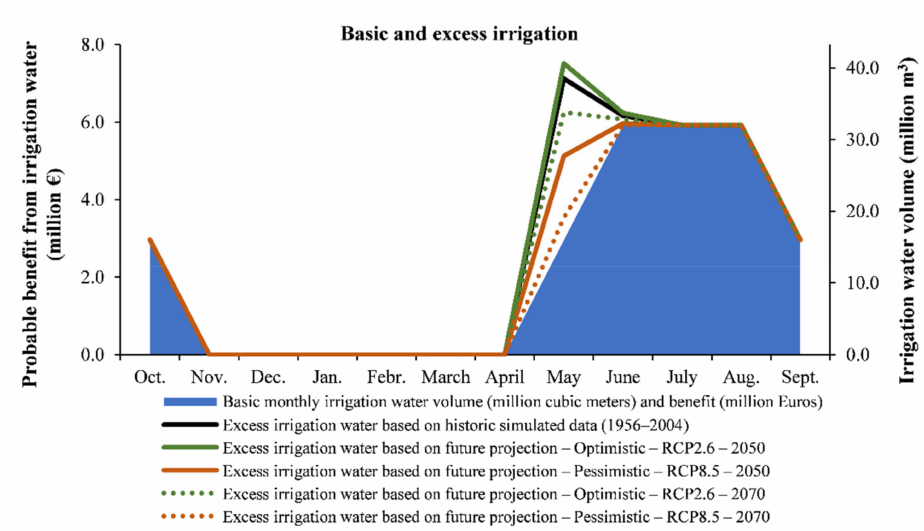
Figure 8. Basic and excess (mean) monthly irrigation water volume (million m 3 ) and corresponding probable benefit (millions € ).